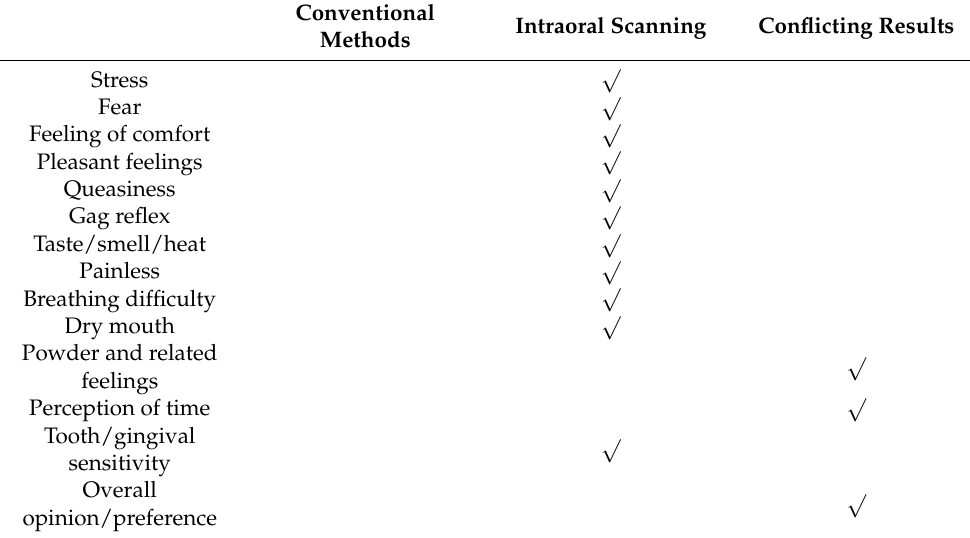
Table 2. Specific aspects of person-reported preferences and